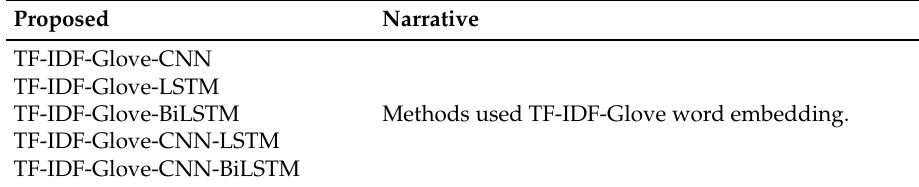
Table 2. Proposed method using a pre-trained word vector GloVe.